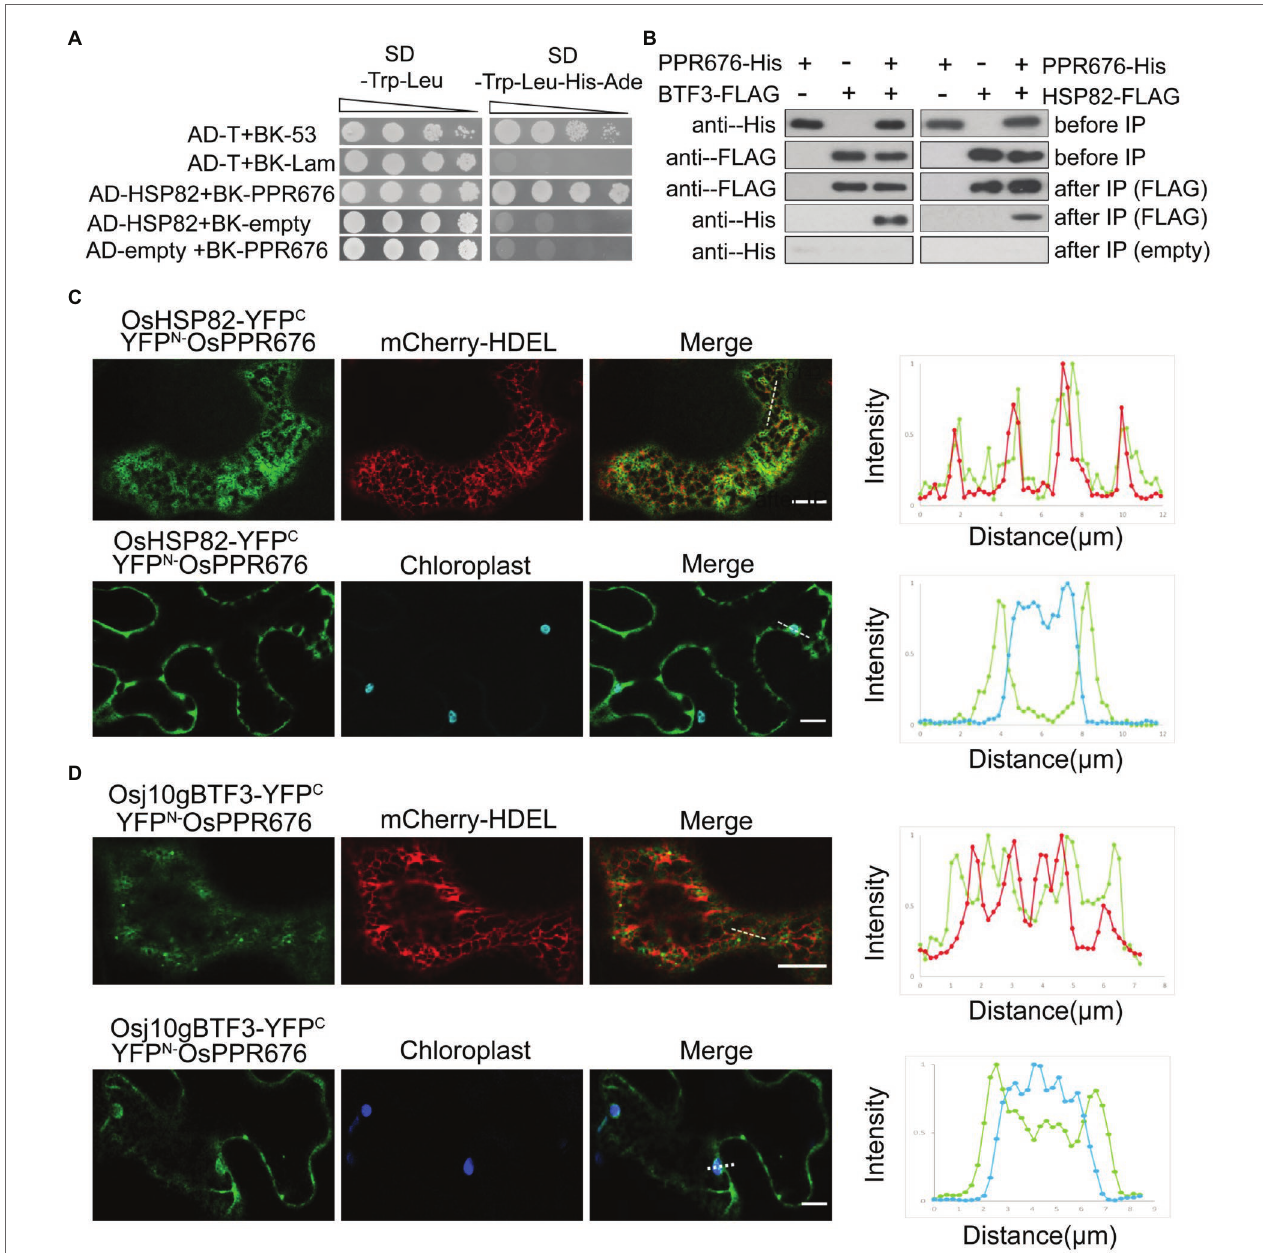
FIGURE 3 | The interaction between Osj10gBTF3/OSHSP82 and OsPPR676 is different. (A) Y2H assays were performed to test the interaction between OsHSP82 and OsPPR676. The pGADT7-T cells co-transformed with pGBKT7-53 or the pGBKT7-Lam were used as positive or negative controls, respectively. Combinations AD-OsHSP82 with BK empty and combinations BK-OsPPR676 with AD empty were also used as negative controls. SD, Synthetic dextrose. (B) Co-IP assays were performed to test the interaction between Osj10gBTF3/OsHSP82 and OsPPR676 using Arabidopsis protoplasts. FLAG antibody conjugated agarose gel was used to co-precipitate OsPPR676. OsHSP82/Osj10gBTF3 and OsPPR676 were detected by FLAG and His antibody, respectively. Three independent replicates were performed for the experiment. (C) and (D) YFP N -OsPPR676 was co-transfected with either OsHSP82-YFP C (C) or Osj10gBTF3-YFP C (D) into the epidermal cells of tobacco. Chloroplast and mCherry-HDEL (endoplasmic reticulum marker) were used as markers. The intensity profile of the dashed line across the ER (top) or the chloroplast (bottom) in the cells was plotted for the quantification of the fluorescence intensity profiles (right). Scale bar = 10 μ m. Negative controls were showed in Supplementary Figure 3